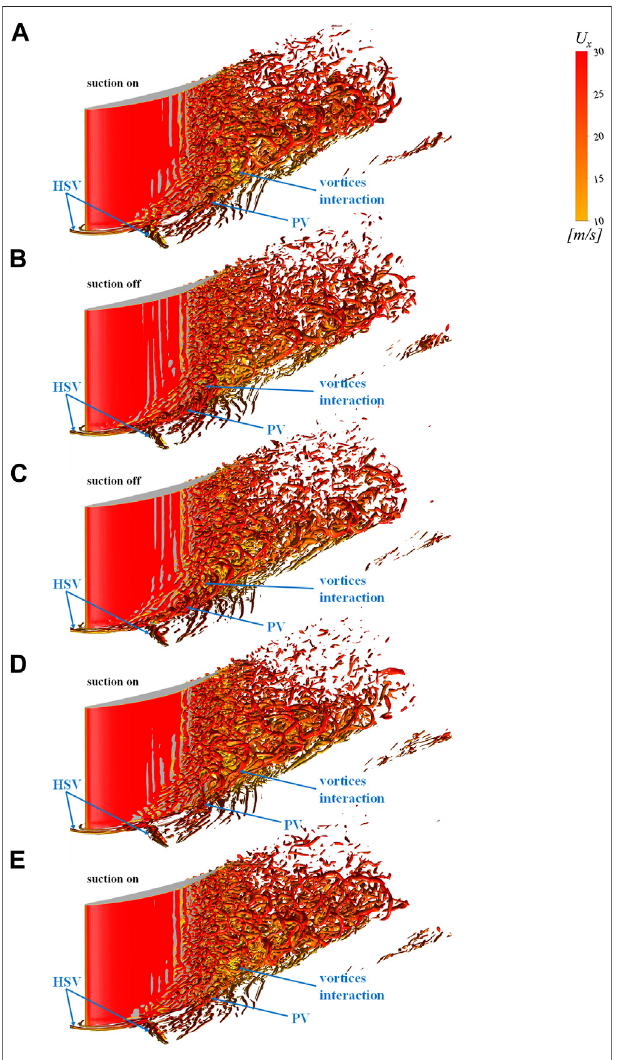
FIGURE 11 | Instantaneous vortex structures for the PS con fi guration ( Q = 5,000,000). (A) t = T; (B) t = T + 1/4 τ (C) t = T + 1/2 τ ; (D) t = T + 3/4 τ ; (E) t = T + τ .